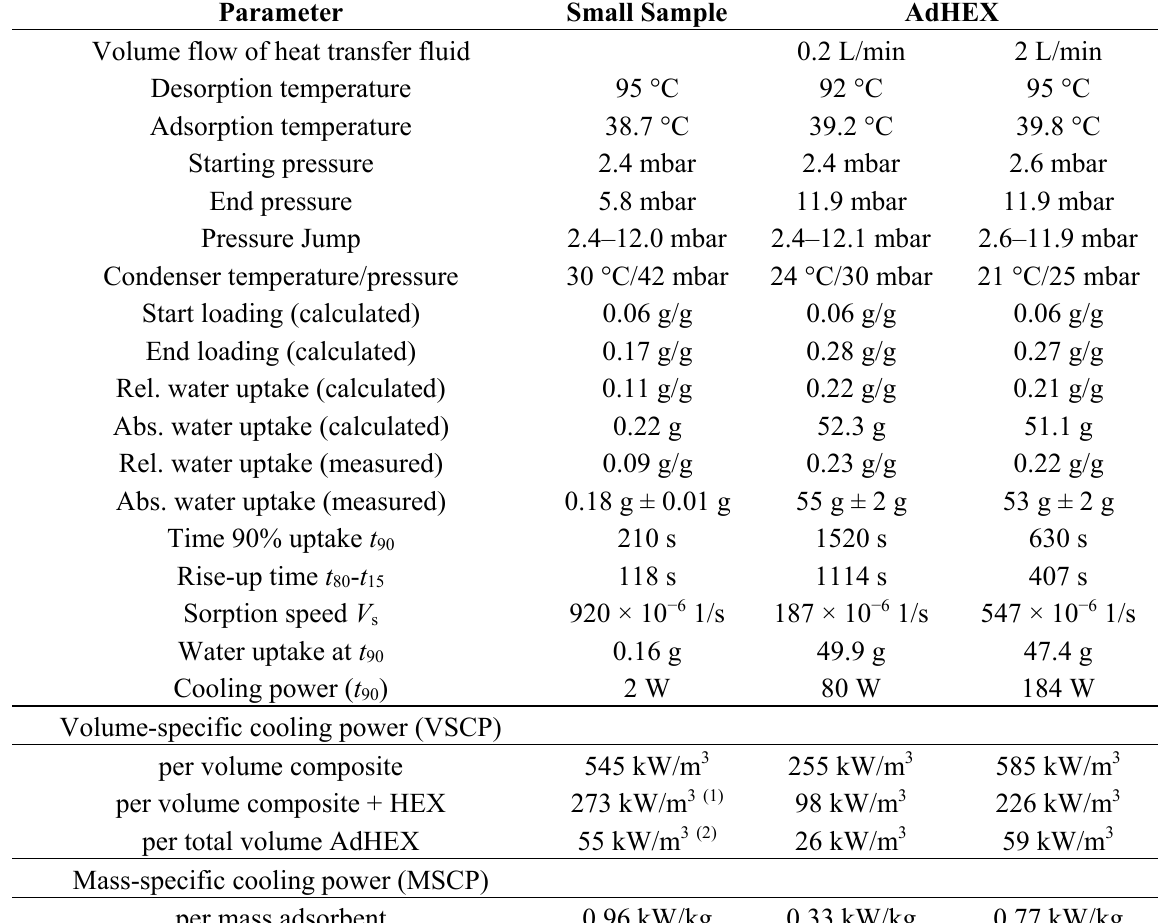
Figure 8. Isotherm at 39 °C for SAPO-34, calculated from the characteristic curve (Equation (2)). Open symbols indicate the start and end loading of all measurements. End loading of AdHEX differs slightly due to deviation in operation conditions (see Table 4). Table 4. Parameters of the experimental characterization and main results of the water uptake